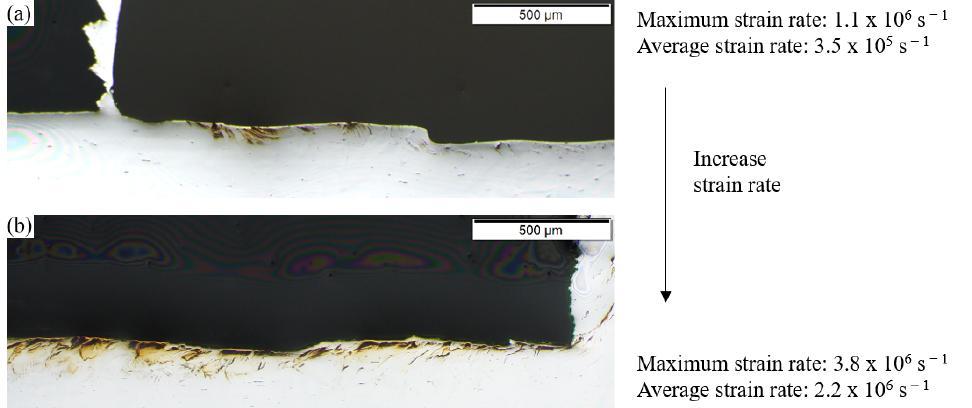
Figure 14. Magnetic etching of specimens from cutting tests at − 45 ◦ C: ( a ) lower strain rate, ( b ) higher strain